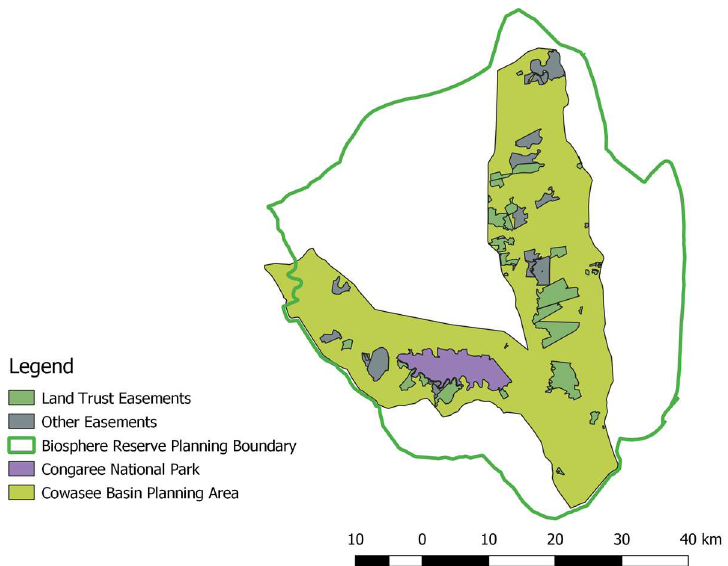
Figure 4. A landscape in South Carolina, USA showing small conservation lands within two overlapping planning projects, an International Biosphere Reserve, and the COWASEE Basin Task Force. Conservation actions within these areas are coordinated to meet landscape-level objectives. QGIS V3.2.